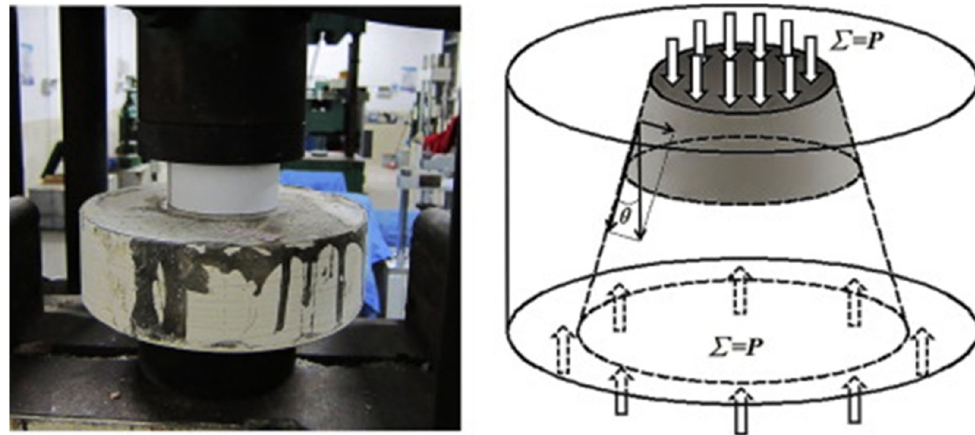
Figure 8. Tests for flexural bond strength between repair materials and concrete substrate [11]. (Adapted and reprinted with permission from ref. 11, © 2014, Construction and Building Materials .).